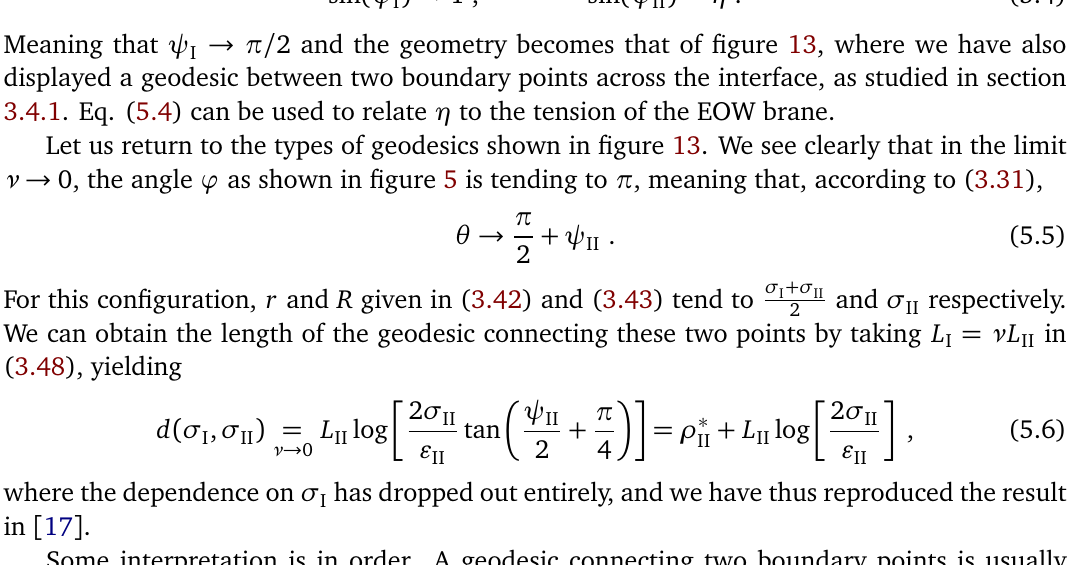
Figure 13: The geodesic for the two point function in the BCFT limit proposed in (2.36). In such regime the angle ψ goes to π/ 2, the length doesn’t depend on σ I anymore and the geodesic approaches the brane at a right angle, as proposed by Takayanagi in [ 17 ]